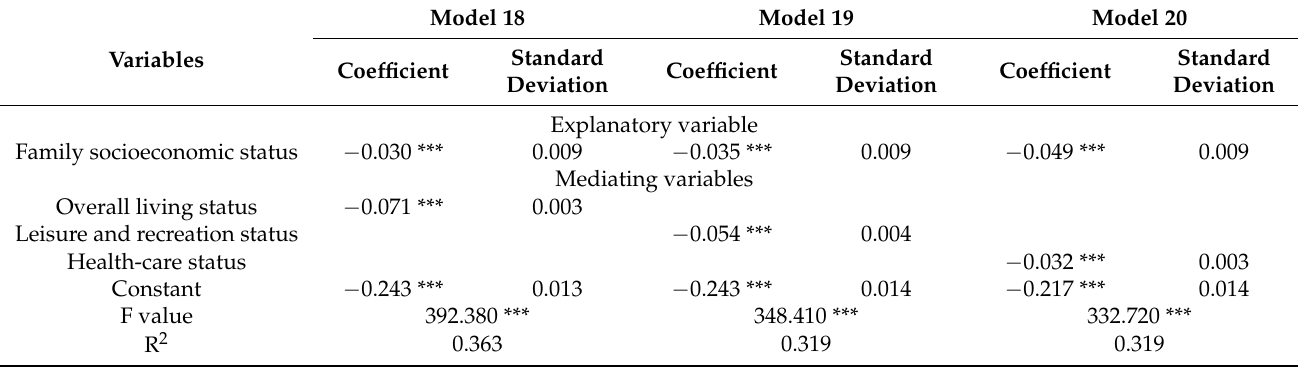
Table 6. Results of multiple linear regression adding mediating variables.